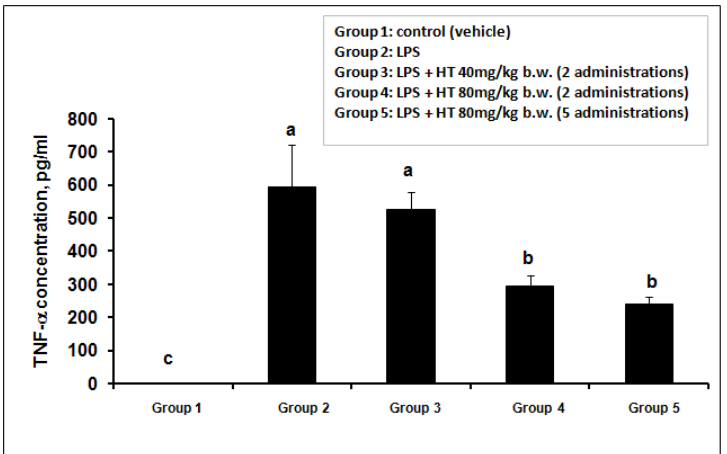
Figure 2. Effect of HT on LPS-induced TNF- α production in mice plasma. 50 µ L/mouse of plasma were used to determine the TNF- α concentration by ELISA kit according to the manufacturer’s instruction. Values are represented as pg/ml. Each bar represents the mean ± S.D. of values obtained from the 8 mice/group. Bars with a different letter are significantly different, p <